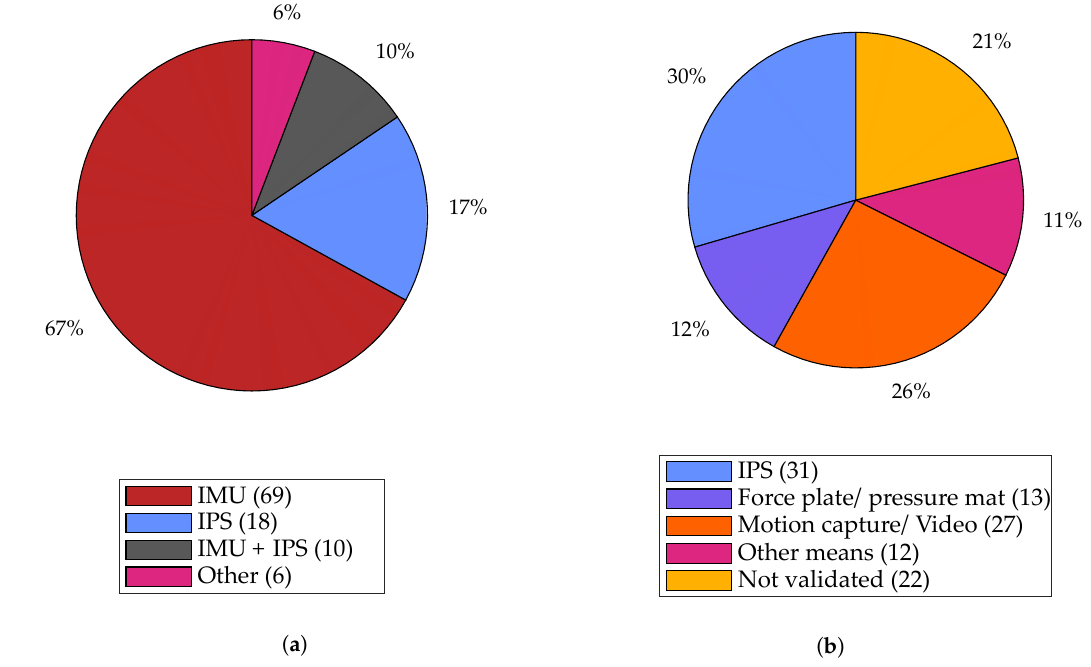
Figure 5. ( a ) Distribution of studies based on the type of wearable sensors used; ( b ) distribution of studies based on the type of sensors used for ground-truth validation of IMU-based gait analysis. Absolute number of studies in each category is listed within parentheses. IMU—inertial measurement unit, IPS—insole pressure sensor, EMG—electromyography